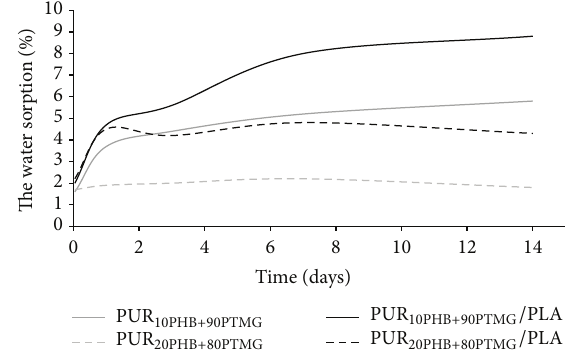
Figure 1: Changes of water sorption by polyether-esterurethanes and their blends with PLA during incubation in deionized water ( ± SD in range 0.0–1.2).